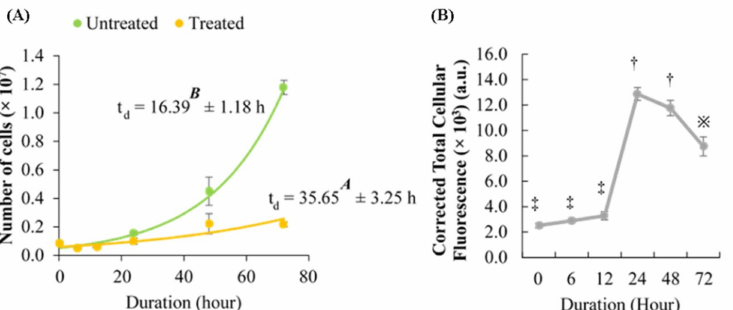
Figure 4. ( A ) Growth curve of untreated and 10.54 µ g/mL berberine-treated HCT 116. Values are mean ± standard error of biological quadruplicate. t d : doubling time. ( B ) Corrected Total Cellular Fluorescence (CTCF) of berberine-treated HCT 116 at different durations. Values are mean ± standard error of biological triplicate. a.u.—arbitrary unit. Mean with different letters or symbols (‡, †, or ※ ) differ significantly at p < 0.001.